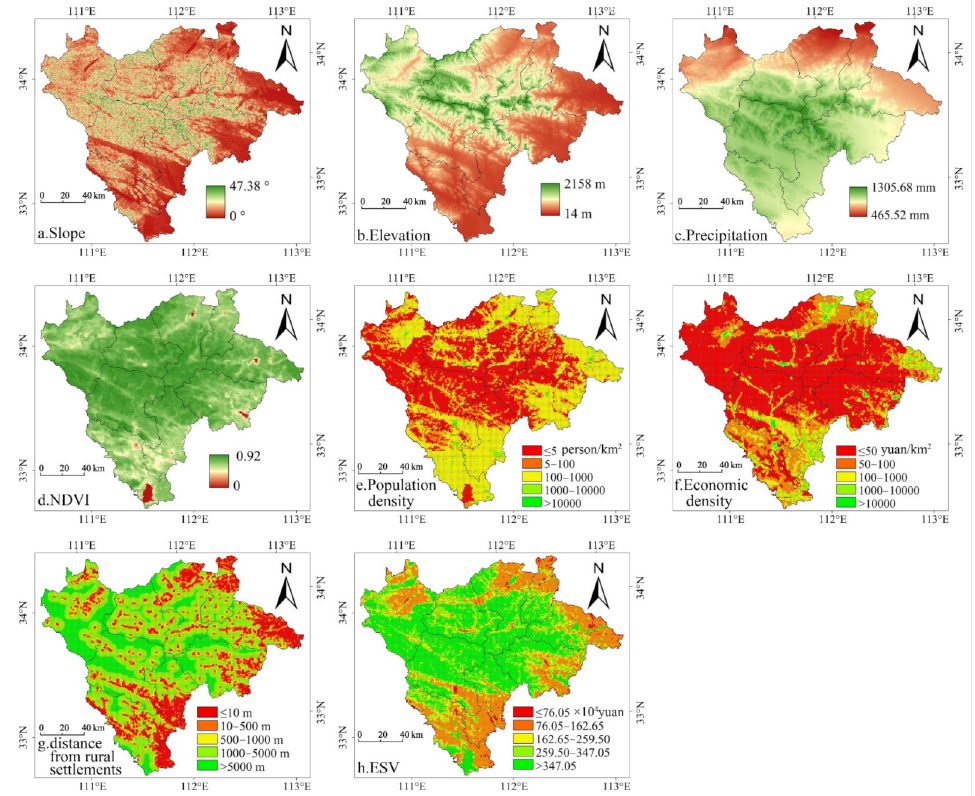
Figure 5. The spatial distribution pattern of different influencing factors of the ESV in the Funiu Mountain area in